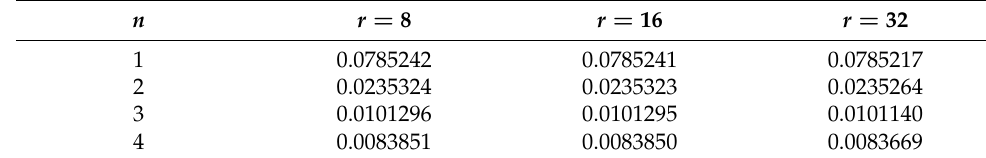
Table 5. (cid:107) x • − x ( n , r ) (cid:107) for Example 4 using the usual basis in L 2 [ 0,1 ] . n r = 8 r = 16 r = 32